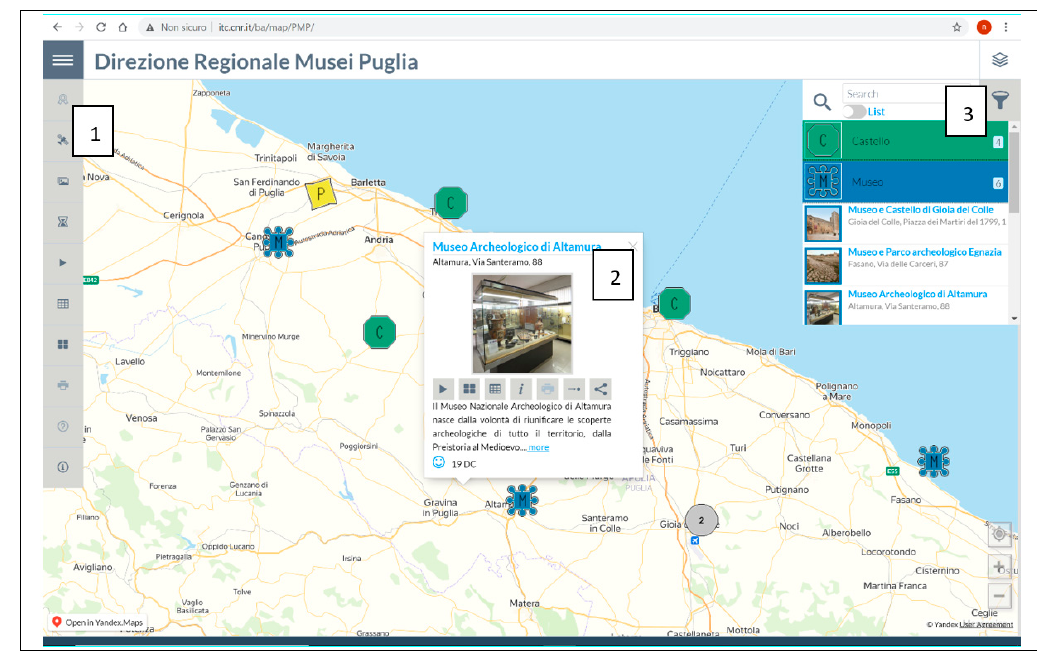
Figure 10. Multimedia interactive map of the “Directorate” [1]: (1) Menu; (2) Callout with information about the selected resource; (3) Sidebar with search box, filter and resource list by type or by name.